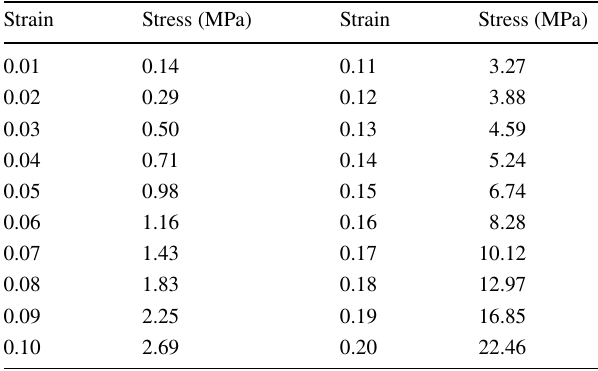
Table 4 The cap pressures of the double-yield model Strain